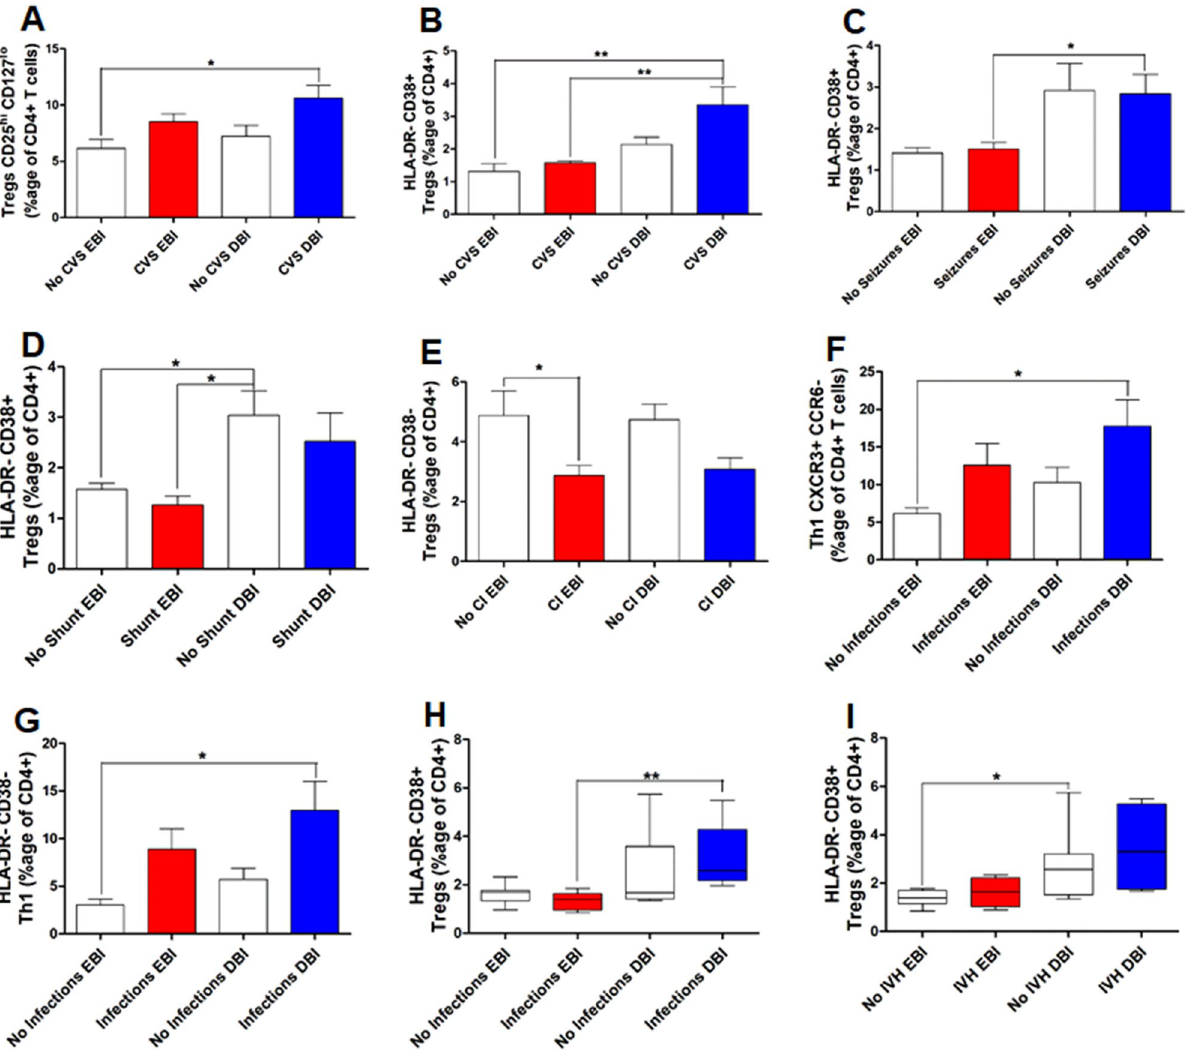
Figure 2. Comparison of peripheral blood: ( A ) Tregs (CD25 hi CD127 lo , expressed as %age of CD3+ CD4+ T cells) after SAH in patients with cerebral vasospasm (CVS) and without CVS during EBI and DBI phases; ( B ) HLA-DR− CD38+ Tregs (expressed as %age of CD3+ CD4+ T cells) after SAH in patients with CVS and with no CVS during EBI and DBI phases; ( C ) HLA-DR− CD38+ Tregs (expressed as %age of CD3+ CD4+ T cells) after SAH in patients with seizures and with no seizures during EBI and DBI phases; ( D ) HLA-DR− CD38+ Tregs (expressed as %age of CD3+ CD4+ T cells) after SAH in patients with shunt dependent chronic hydrocephalus and with no shunt dependent chronic hydrocephalus during EBI and DBI phases; ( E ) HLA-DR− CD38− Tregs (expressed as %age of CD3+ CD4+ T cells) after SAH in patients with cerebral ischemia/infarction (CI) and with no CI during EBI and DBI phases; ( F ) Th1 cells (CXCR3+ CCR6− , expressed as %age of CD3+ CD4+ T cells) after SAH in patients with infections and without infections during EBI and DBI phases; ( G ) HLA-DR− CD38− Th1 cells (expressed as %age of CD3+ CD4+ T cells) after SAH in patients with infections and without infections during EBI and DBI phases; ( H ) HLA-DR− CD38+ Tregs (expressed as %age of CD3+ CD4+ T cells) after SAH in patients with infections and without infections during EBI and DBI phases; ( I ) HLA-DR− CD38+ Tregs (expressed as %age of CD3+ CD4+ T cells) after SAH in patients with IVH and without IVH during EBI and DBI phases. One way ANOVA followed by Tukey’s/Bonferroni’s multiple comparisons test for normally distributed data. Kruskal Wallis test followed by Dunn’s multiple comparisons test for non- normally distributed data; A p value < 0.05 was considered as a significant difference. *Indicates a p value < 0.05, **indicates a p value < 0.01, ***indicates a p value < 0.001. EBI early brain injury phase after SAH covering days 1–3 (n = 15), DBI delayed brain injury phase after SAH covering days 7–9 (n =